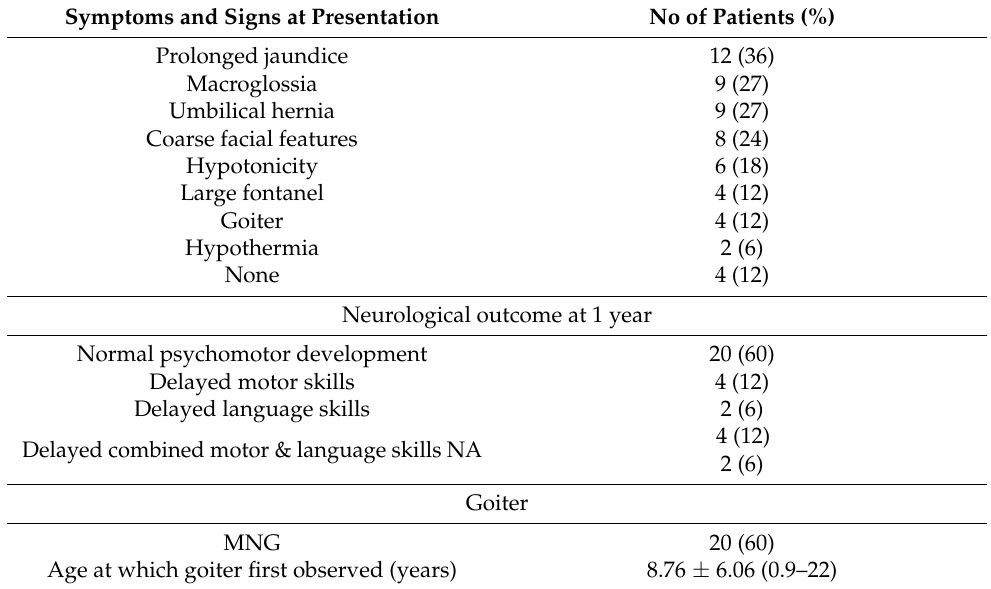
Table 2. Clinical characteristics of all patients with TPO enzyme deficiency. Symptoms and Signs at